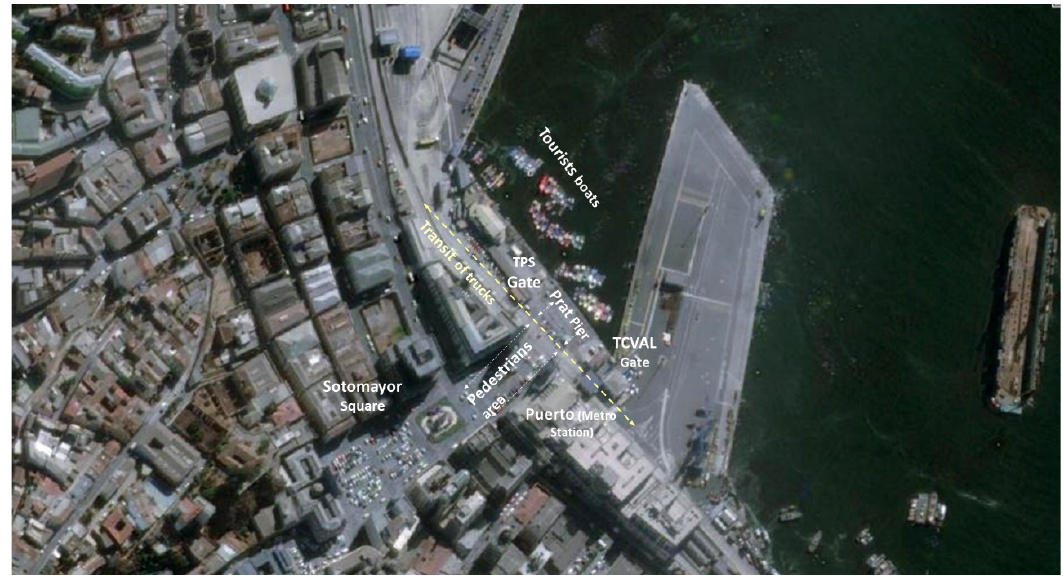
Figure 4. Prat Pier (Muelle Prat). Source: Own elaboration using Google